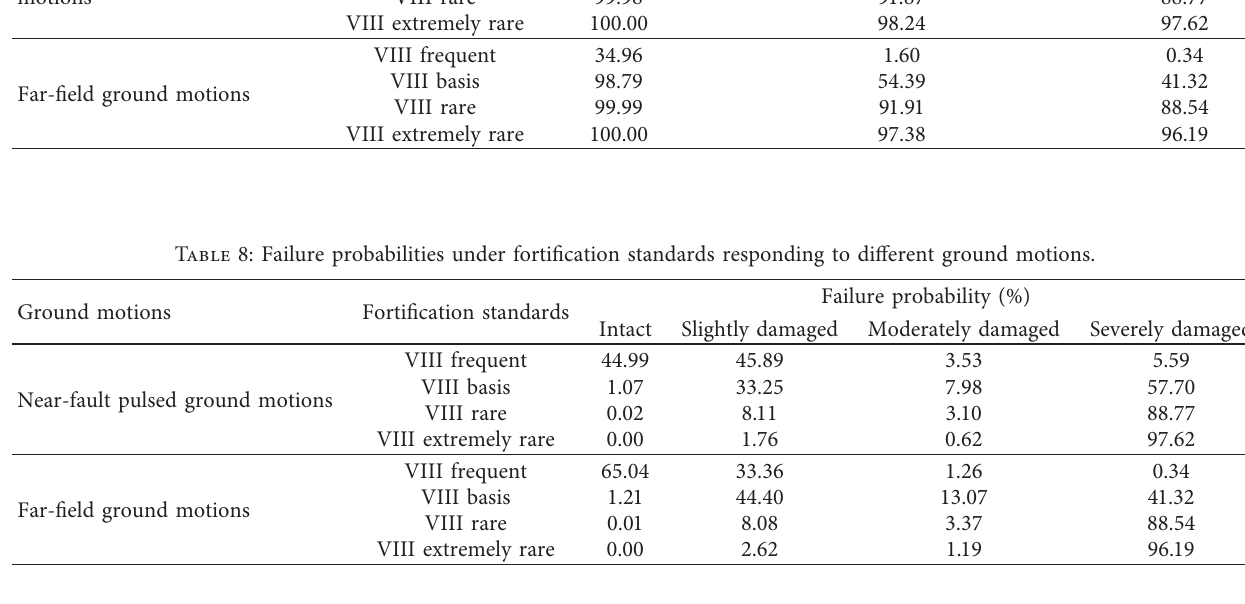
Table 7: Exceeding probabilities under fortification standards responding to different ground motions. Fortification Normal Exceed probability/% available after Ground motions standards service Near-fault pulsed ground motions